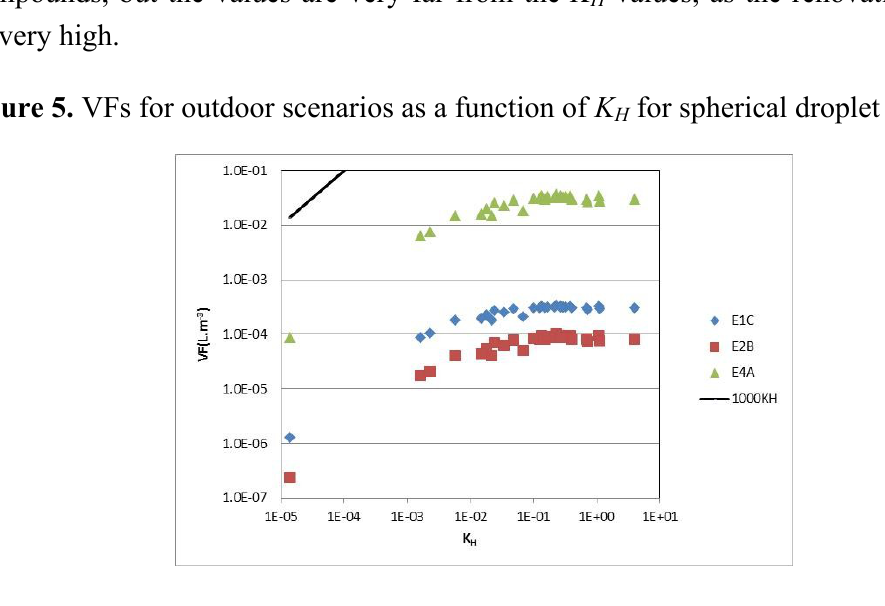
Figure 5. VFs for outdoor scenarios as a function of K